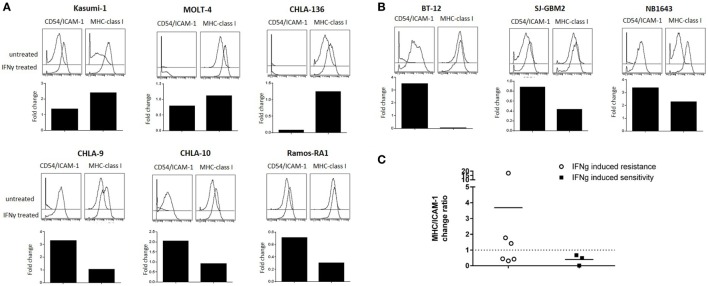
Effect of IFNγ treatment on intercellular adhesion molecule 1 (ICAM-1) and major histocompatibility complex (MHC)-class I expression for cancer cell lines with altered sensitivity. The effect of IFNγ on ICAM-1 and MHC-class I expression for cell lines in which IFNγ treatment conferred (A) resistance or (B) sensitivity to NK cell-mediated lysis. Histograms compare ICAM-1 (left) and MHC-class I (right) expression for untreated cancer cells (top) and IFNγ-treated cells (bottom). Bar graphs represent ICAM-1 and MHC-class I fold change in median expression after IFNγ treatment. (C) Ratio of MHC-class I/ICAM-1 change after IFNγ treatment for cell lines with altered sensitivity. Fold change in median expression after IFNγ treatment for each parameter was quantified and the ratio was calculated. Ratio <1 indicates higher ICAM-1 upregulation and ratio >1 indicates higher MHC-class I upregulation after IFNγ treatment.